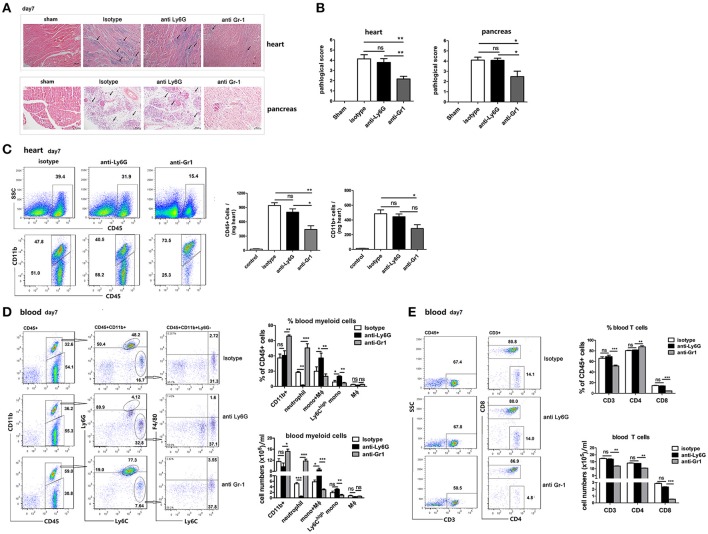
Gr-1 cell depletion ameliorate CVB3 myocarditis and pancreatitis which was associated with a reduction in blood Ly6Chigh monocytes. (A) Representative image of HE-staining hearts and pancreas of CVB3-infected mice (day 7 p.i.) treated with isotype, anti-Ly6G or anti-Gr1, showing intra-cardiac immune infiltrates or damaged pancreatic acini (marked with arrows). Scale bar: 100 μm (heart) and 50 μm (pancreas). (B) Pathological scores of the heart and pancreas of mice are shown. Results are presented as mean ± SEM; Data pooled from three independent experiments. (C) Representative FACS plots of intra-cardiac total CD45+ leukocytes and CD11b+ cells of an individual mouse from each group (n = 5) on day7 p.i. Means ± SEM for frequencies and absolute numbers of cardiac CD45+ and CD11b+ myeloid cells were shown. (D) Representative FACS plots of CD11b+,Ly6G+Ly6C- neutrophils, Ly6Chigh Ly6G- monocytes, and F4/80+ macrophages in the blood of CVB3-infected mice treated with anti-Ly6G or anti-Gr1 on day7 p.i. (pre-gated on CD45+ cells). Means ± SEM for frequencies and absolute numbers of neutrophils, Ly6Chigh monocytes and macrophages within the CD45+ gate were shown. (E) Representative FACS plots, Means ± SEM for frequencies and absolute numbers of blood CD3+, CD4+, and CD8+ T cells were shown. Similar results were obtained in three separate experiments (n = 6). *p < 0.05; **p < 0.01; ***p < 0.001.